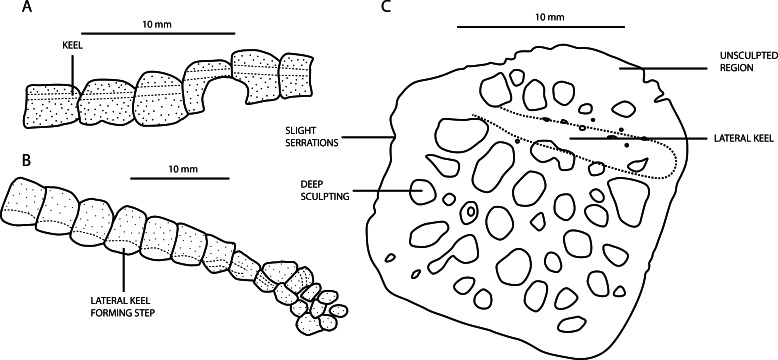
(A) Line drawings of the dorsal osteoderms of A. bavaricus; (B) line drawings of the cervical and dorsal osteoderm series of A. beaumonti; (C) Line drawing of a dorsal osteoderm of the specimen described as Alligatorellus sp. (MfN MB. R. 4317.1-12) by Schwarz-Wings et al. (2011), but considered here as Atoposauridae indet.